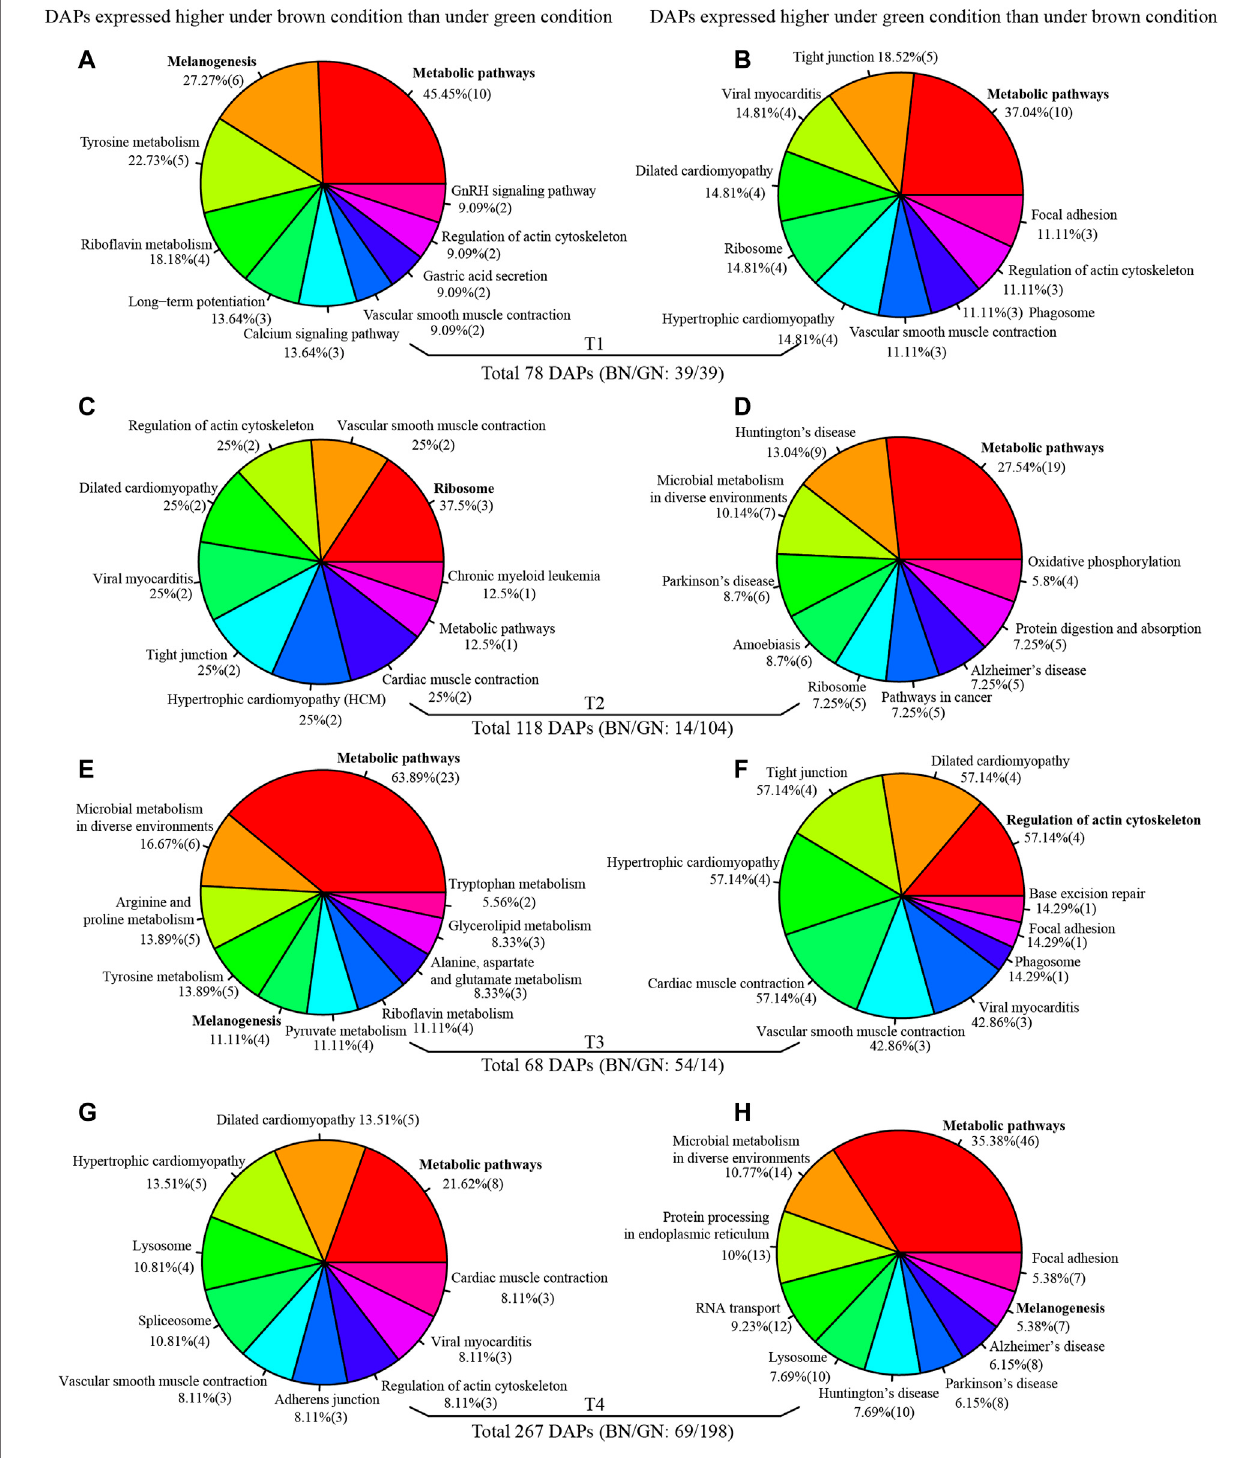
FIGURE 4 | KEGG enrichment analysis of different abundance proteins (DAPs) at T1 (A,B) , T2 (C,D) , T3 (E,F) , and T4 (G,H) . Full information of periods refers to Figure 1 .